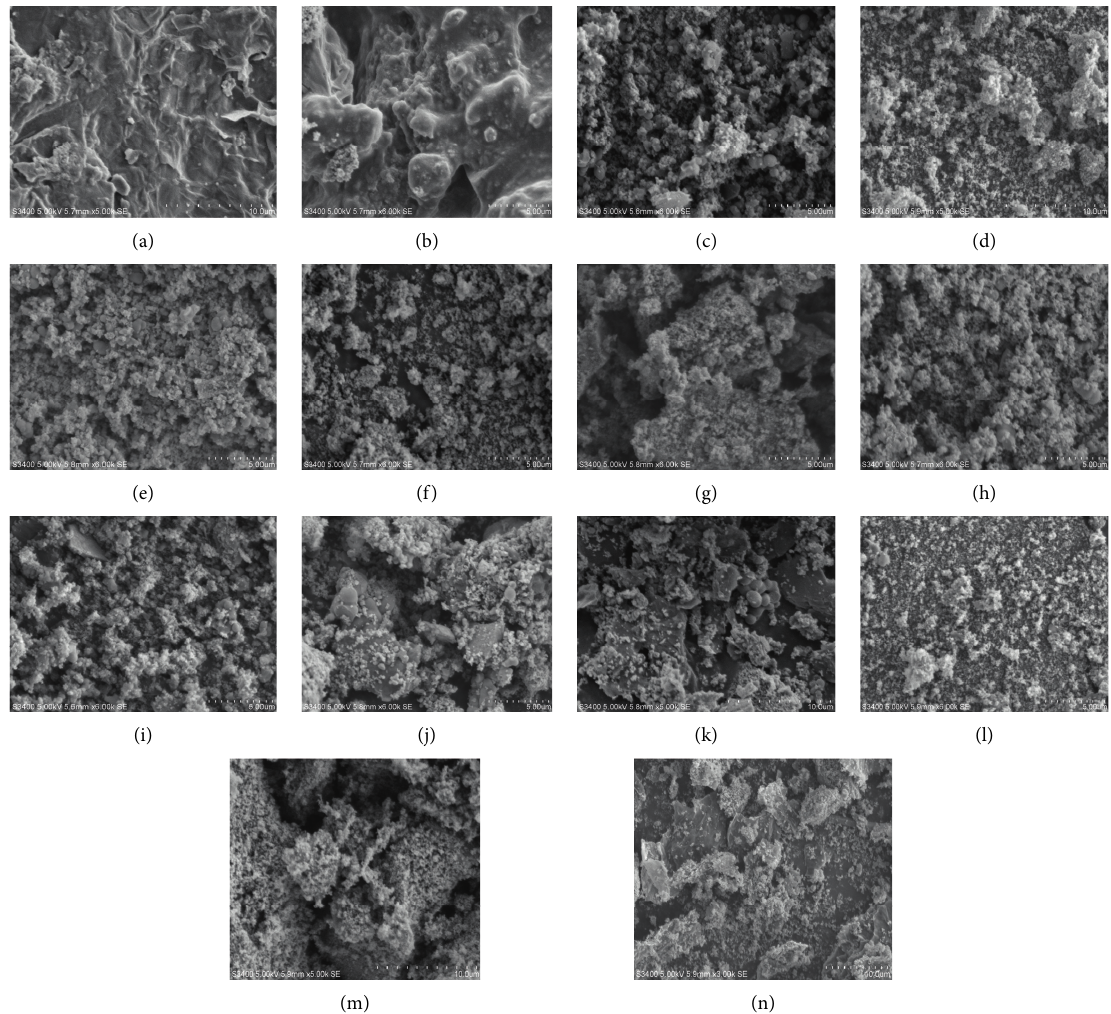
Figure 5: SEM micrograph of green synthesized rGO/ Citrus sinensis peel (a), rGO/ Musa acuminata peel (b), TiO (d), TiO 2 -1.5c (e), TiO 2 -0.5m (f), TiO 2 -1m (g), TiO 2 -1.5 m (h), TiO 2 /rGO-0.5 (i), TiO 2 /rGO-1c (j), TiO 2 /rGO-1.5c (k), TiO 2 /rGO-0.5 m (l), TiO 2 /rGO-1 m, (m), and TiO 2 /rGO-1.5 m